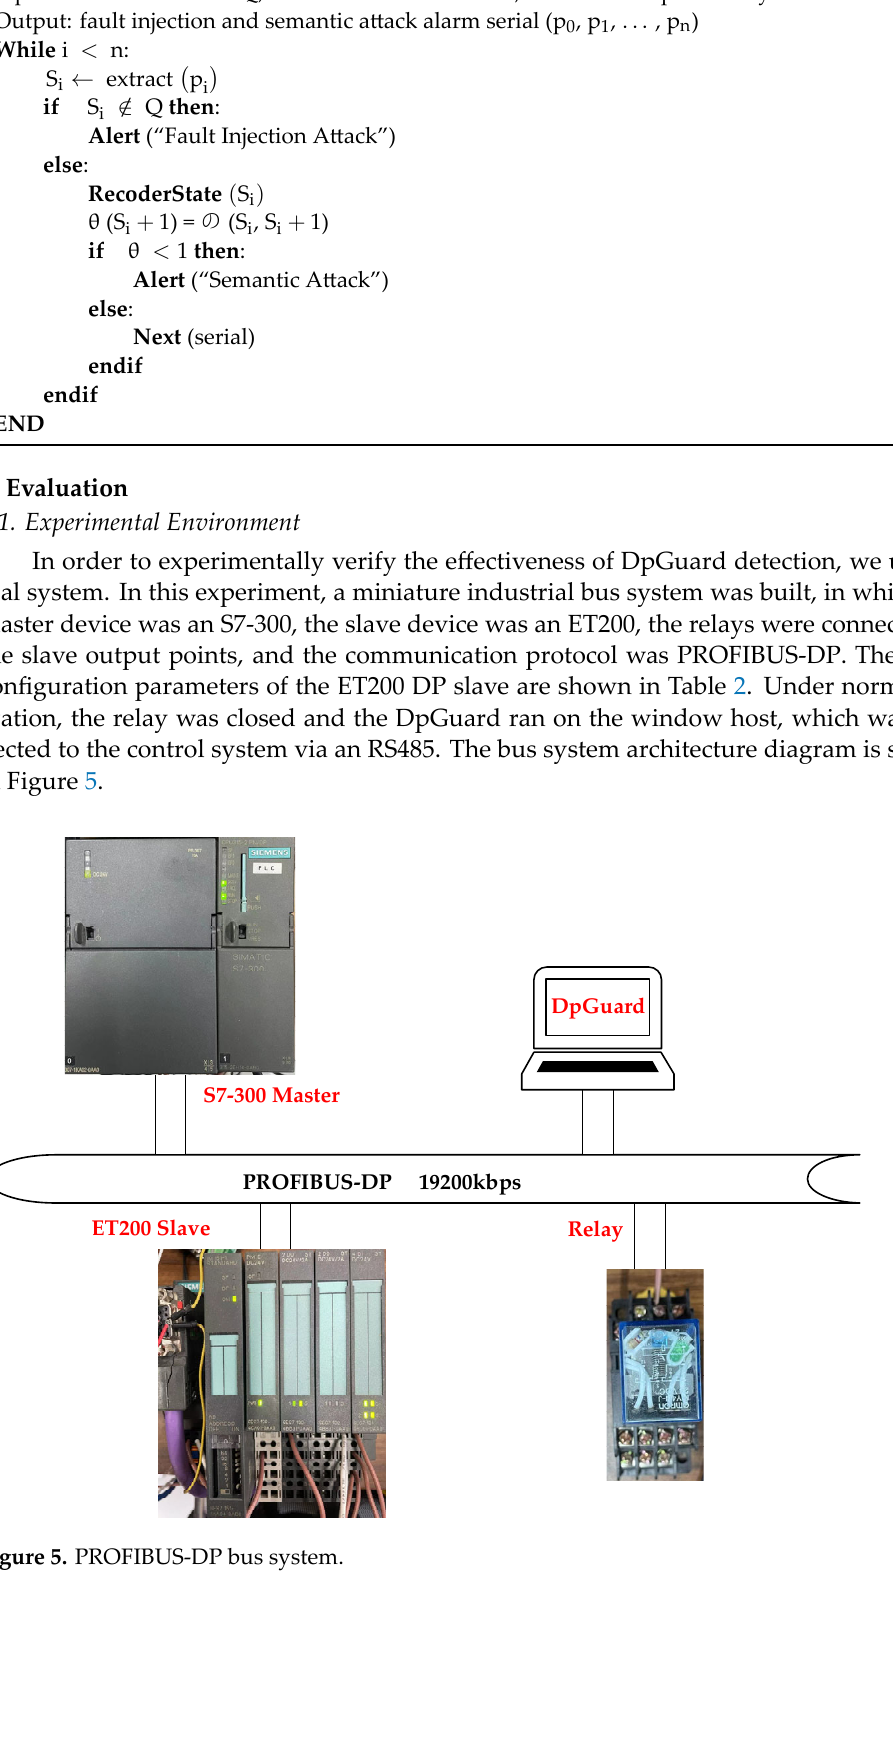
Algorithm 1 Finite‑state Machine (M) Detection Attack Algorithm